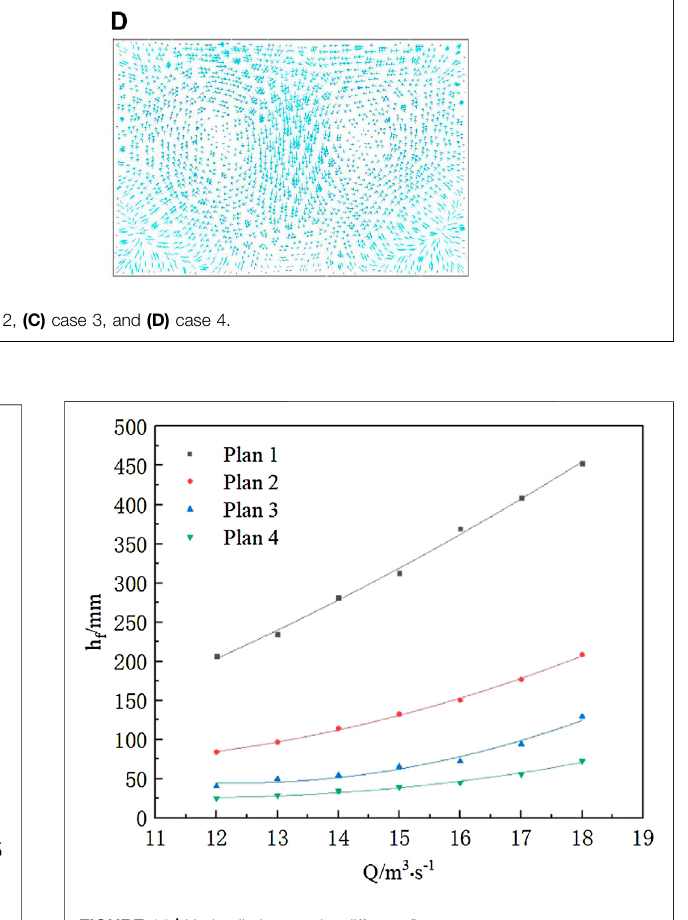
FIGURE 13 | Velocity uniformity at different distances.